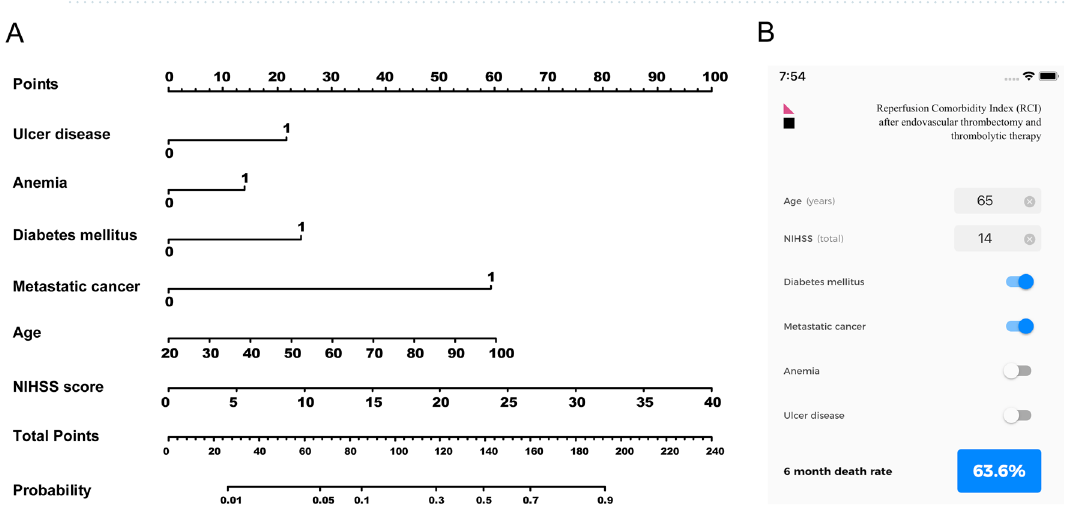
Figure 2. Nomogram ( A ) predicting mortality within 6 months and smartphone application ( B ). NIHSS, National Institutes of Health Stroke Scale